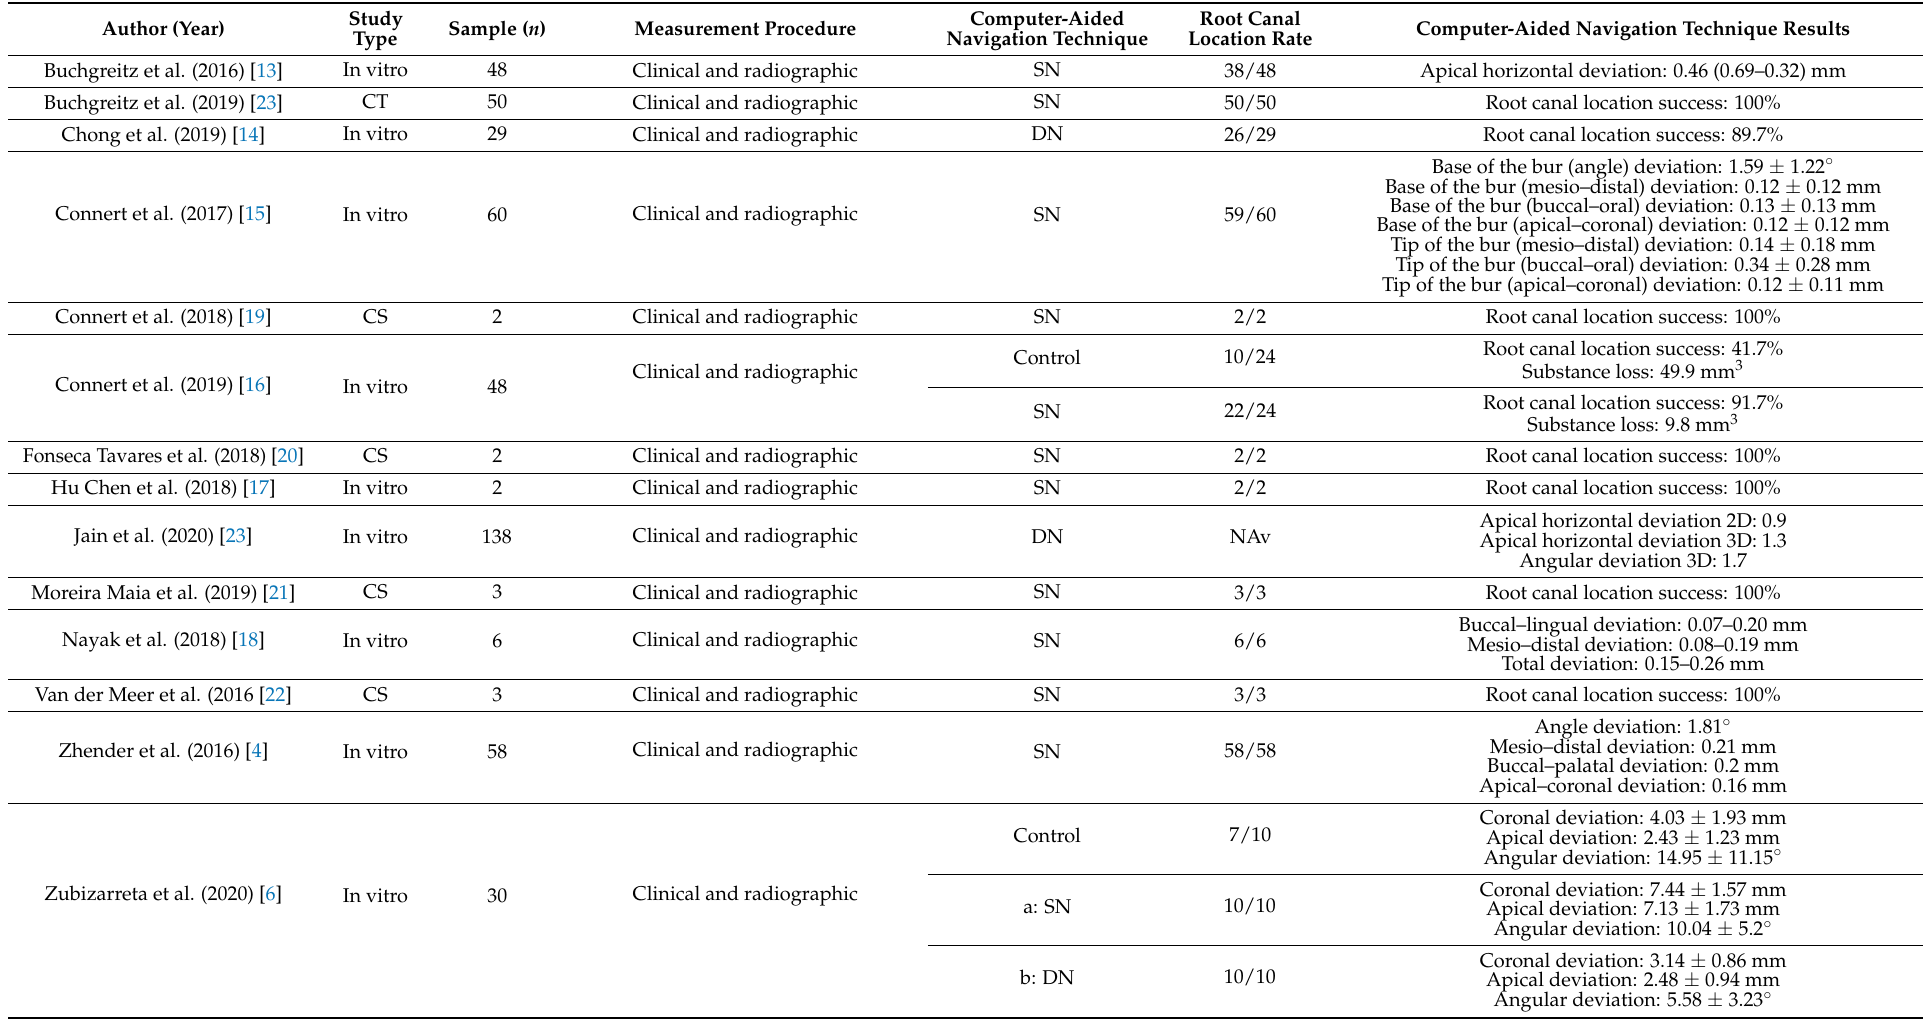
Table 1. Qualitative analysis of articles forming part of the systematic